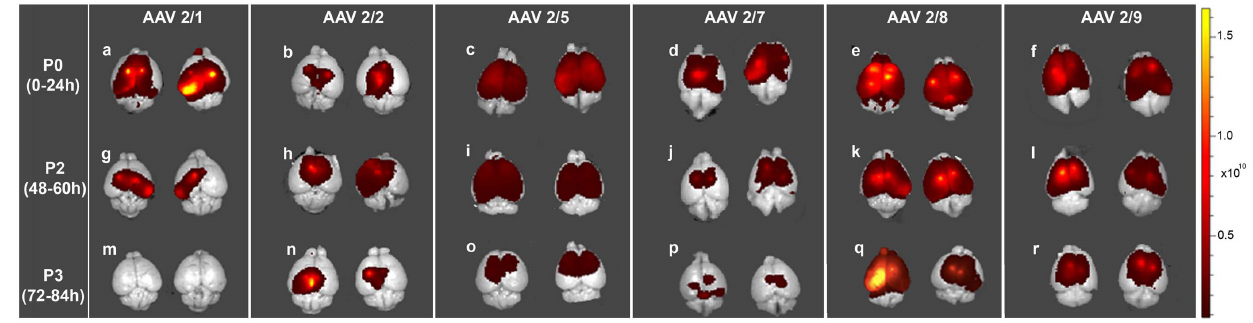
Figure 2. Comparative biodistribution of pseudotyped AAVs injected at different neonatal ages in mice detected by Xenogen IVIS Spectrum fluorescence imager. Wild type mice were injected into the cerebral ventricles with pseudotyped AAV2/n-EGFP on different neonatal days (P0, P2 and P3) and analyzed on day P21. Representative pseudo color images from each group (standardized to non-injected control brain) show differential fluorescent intensities depending on serotype injected and timing of virus injection. n=3–4/time